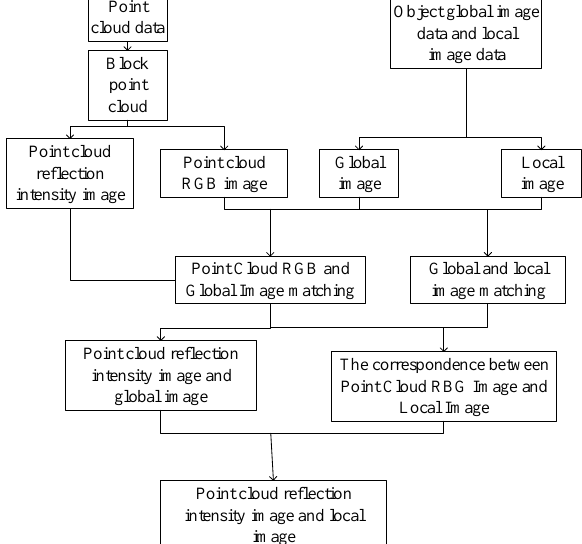
Figure 4. One-to-one flow chart of point cloud and image